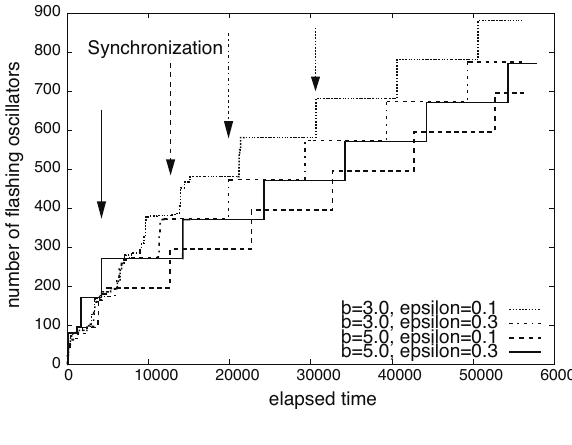
Figure 4. Cumulative number of flashing